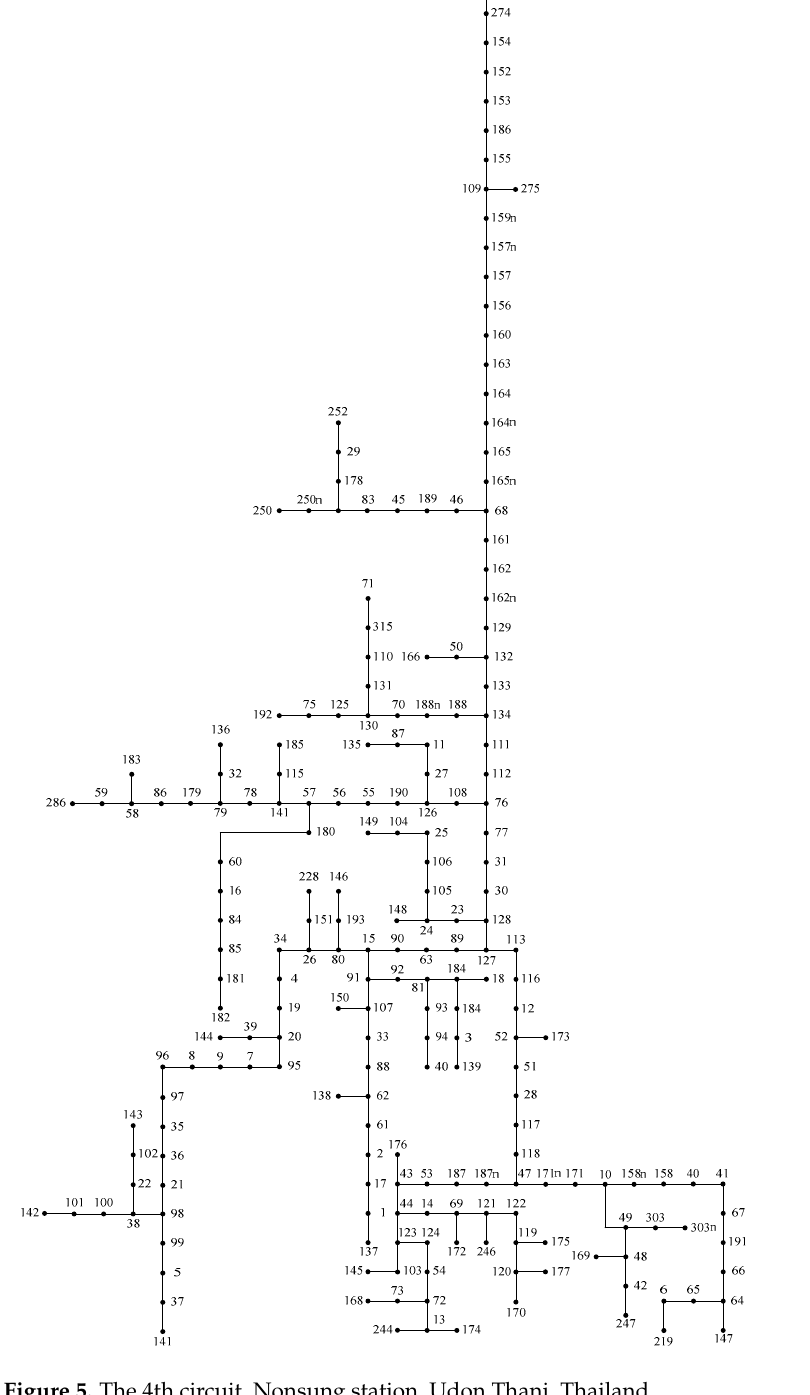
Figure 5. The 4th circuit, Nonsung station, Udon Thani, Thailand.